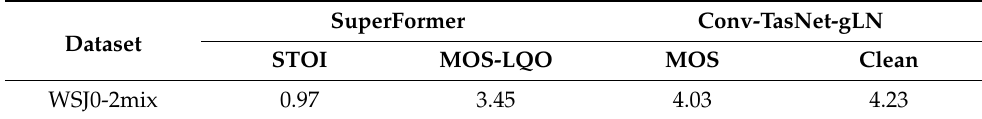
Table 3. STOI and MOS-LQO scores on the WSJ0-2mix dataset. Dataset